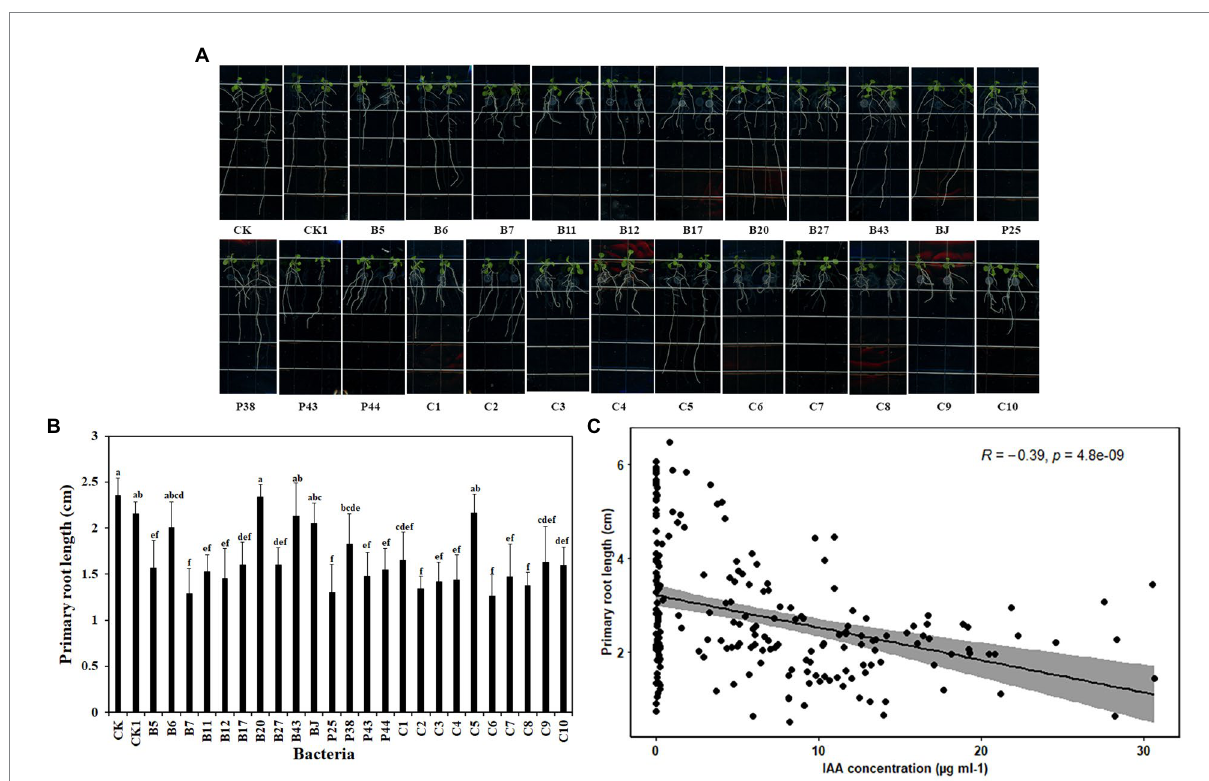
FIGURE 3 Effects of bacteria on root growth of Arabidopsis thaliana . (A) . The root system of A. thaliana grown on MS medium. (B) . The square-root-transformed primary root length of Arabidopsis . (C) . The correlation of the primary root length of Arabidopsis and IAA concentration. CK: Arabidopsis only; CK1: Arabidopsis and ddH 2 O; B5: Arabidopsis and Pseudomonas sp. B5; B6: Arabidopsis and Streptomyces sp. B6; B7: Arabidopsis and Chryseobacterium sp. B7; B11: Arabidopsis and Pseudomonas sp. B11; B12: Arabidopsis and Pseudomonas sp. B12; B17: Arabidopsis and Sphingomonas sp. B17; B20: Arabidopsis and Cupriavidus campinensis B20; B27: Arabidopsis and Asticcacaulis sp. B27; B43: Arabidopsis and Rhodococcus erythropolis B43; BJ: Arabidopsis and Janthinobacterium lividum BJ; P25: Arabidopsis and Pseudomonas sp. P25; P38: Arabidopsis and Chryseobacterium soldanellicola P38; P43: Arabidopsis and Chryseobacterium sp. P43; P44: Arabidopsis and Pedobacter sp. P44; C1: Arabidopsis and SynCom 1; C2: Arabidopsis and SynCom 2; C3: Arabidopsis and SynCom 3; C4: Arabidopsis and SynCom 4; C5: Arabidopsis and SynCom 5; C6: Arabidopsis and SynCom 6; C7: Arabidopsis and SynCom 7; C8: Arabidopsis and SynCom 8; C9: Arabidopsis and SynCom 9; C10: Arabidopsis and SynCom 10. The values are means ± SD. Different letters indicate significant differences ( p ≤ 0.05, Tukey’s test, n =